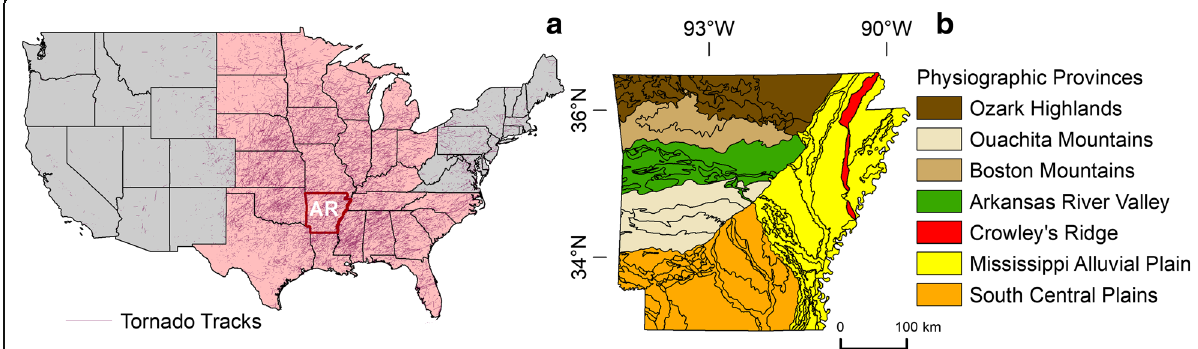
Fig. 1 a Light red region indicates the highest frequency of tornadoes in the United States of America. AR denotes the State of Arkansas. b Physiographic provinces of Arkansas that have topographic and land surface features influencing severe weather patterns